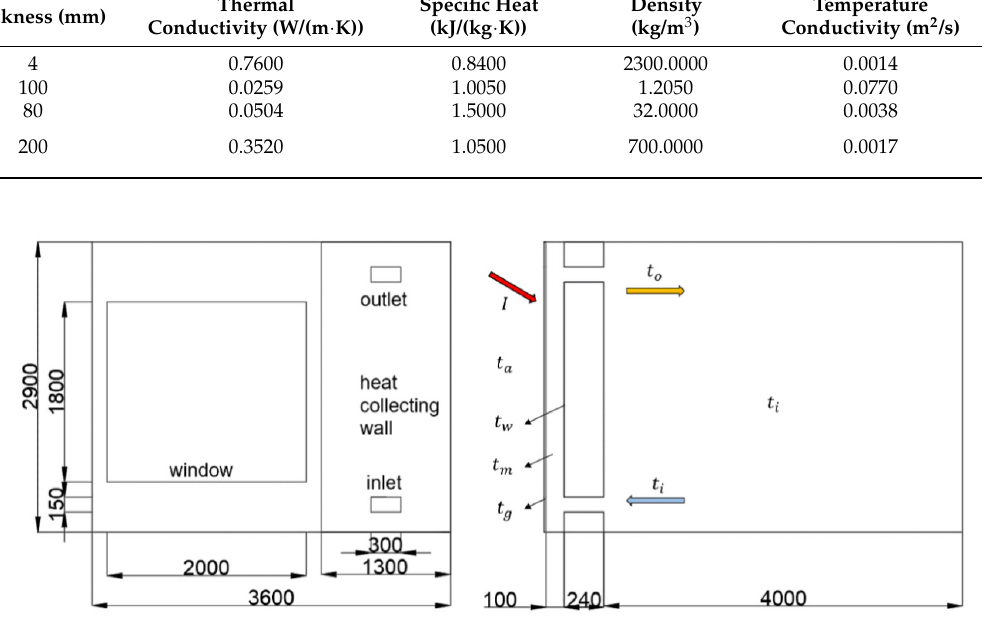
Figure 13. Plan and elevation of heat collection wall and operating principle in winter.